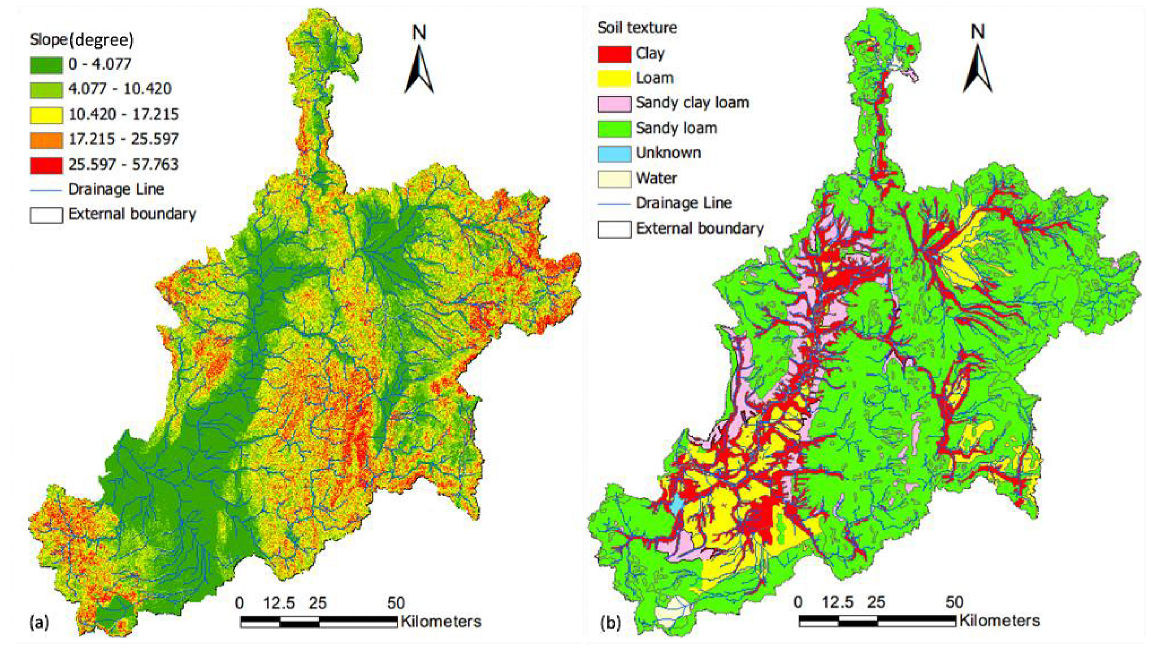
Figure 5. Schematic showing the slope (a) and soil texture (b) in the Ishikari River